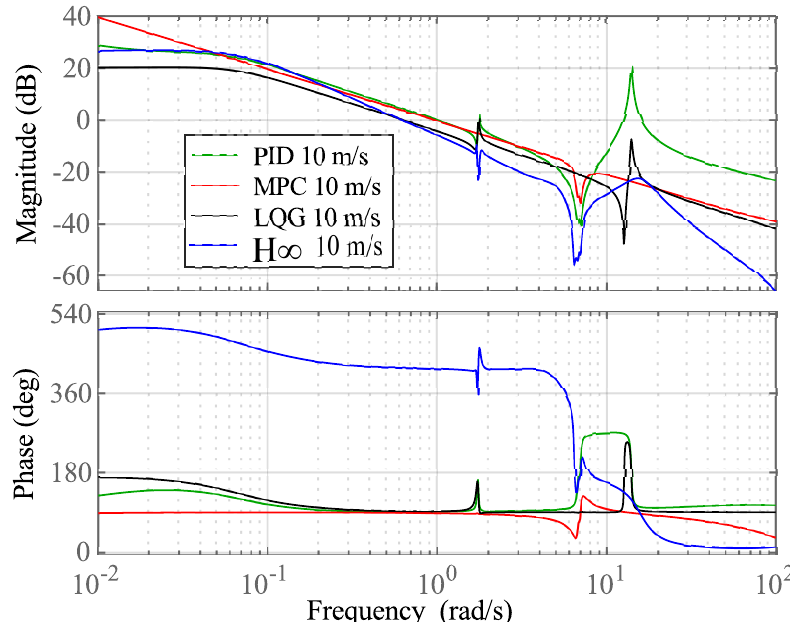
Figure 14. Open–loop frequency responses of PID, MPC, LQG, and H ∞ controllers based on Bladed linearized model in mode 2.